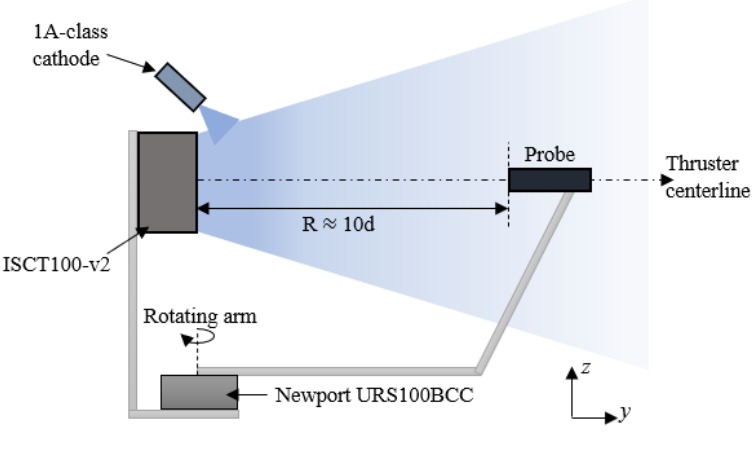
Figure 3. Schematic of the experimental set-up used for far-field plume measurements. The probe is aligned with the ISCT100-v2 centerline at the position θ = 0 ◦